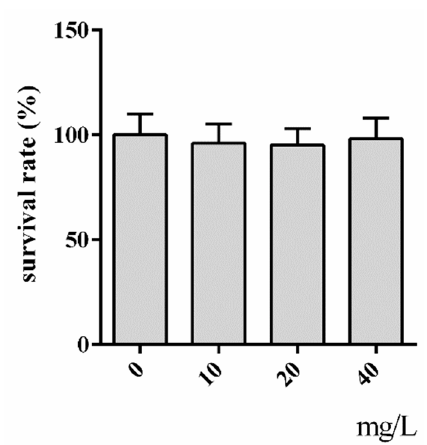
Figure 2. Survival of exponential WT cells exposed to increased concentrations of hyperoside .